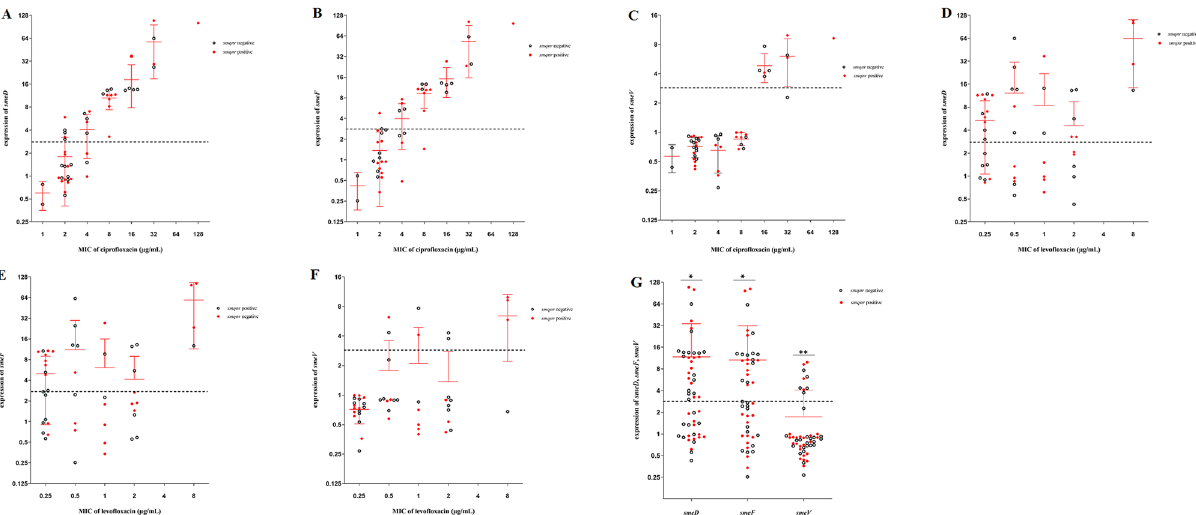
Figure 2. Expression level of smeD , smeF , and smeV genes in Stenotrophomonas maltophilia strains. ( A – C ) smeD , smeF , and smeV expression level and distribution of ciprofloxacin MICs, ( D – F ) smeD , smeF , and smeV expression level and distribution of levofloxacin MICs, ( G ) the mean expression level of smeD , smeF , and smeV genes among the S. maltophilia isolates. Red lines showing the mean ± SD for each group and the dash line indicates the level of gene expression above which overexpression is considered, *expression level of smeD (p = 0.01) and smeF (p = 0.003) genes was significantly associated with the reduced MICs of ciprofloxacin, **the corelation of smeV expression level with the MICs of both ciprofloxacin (p = 0.000) and levofloxacin (p = 0.03) was